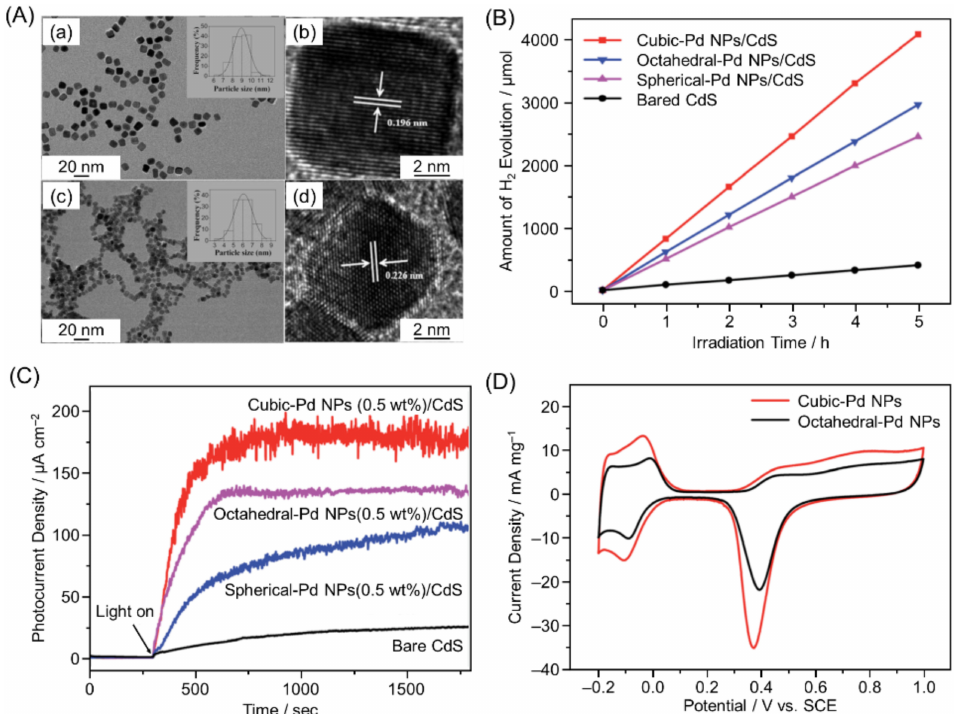
Figure 25. ( A ) TEM images of ( a ) cubic-Pd NPs and ( c ) octahedral-Pd NPs, and HR-TEM images of single ( b ) cubic-Pd NPs and ( d ) octahedral-Pd NPs. Insets in ( a ) and ( c ) are the size distributions of each Pd nanocrystal. ( B ) H 2 evolution from 0.125 M ammonium sulfite ((NH 4 ) 2 SO 3 ) • H 2 O